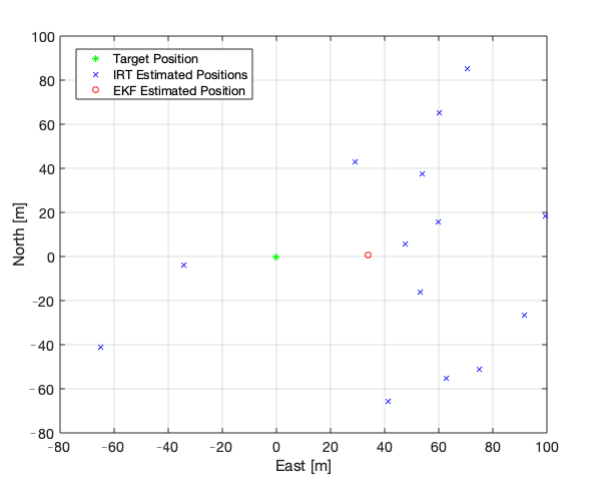
Figure 13. Real position of the target (green), IRT measurements (blue) and estimated position with the EKF